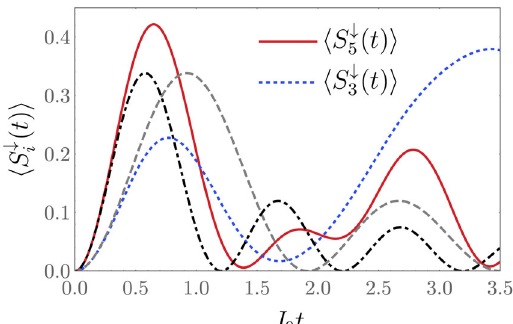
Fig. 4 Time evolution of the impurity at the sites adjacent to the center of a chain with N = 7. Here, k B Δ T = 2 ϵ 0 , where k B is the Boltzmann constant and ϵ 0 is the energy per particle in the thermodynamic limit. The red solid (blue dotted) curve shows the result obtained with Eq. (2) for h S # ð t Þi 5 ( h S # ð t Þi ). The remaining curves show the predictions of Eq. (7) with 3 α = α ( T α = α ( T = 5. Note 1 ) (gray, dashed) and 2 ) (black, dot-dashed) at i that Eq. (7) implies identical probabilities for i = 3 and i = 5. On the horizontal axis, J 0 = α 1 / g , where α 1 is the value of the exchange coef fi cients at T = 0, and g is the interaction strength. All presented quantities are